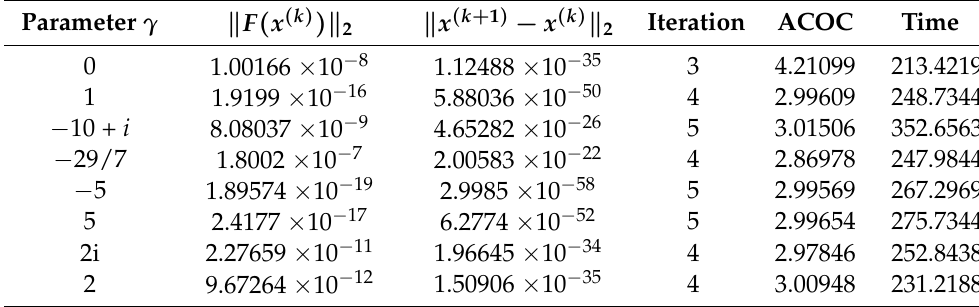
Table 3. Fisher results for different parameters. Parameter